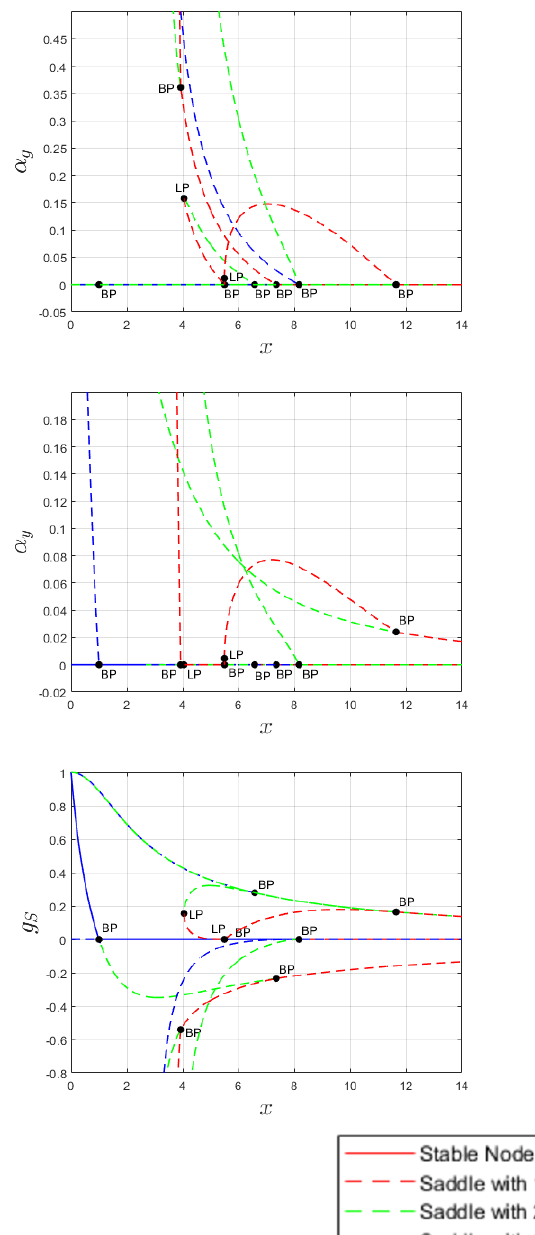
g )-plane, ( x; (cid:11) y )-plane,